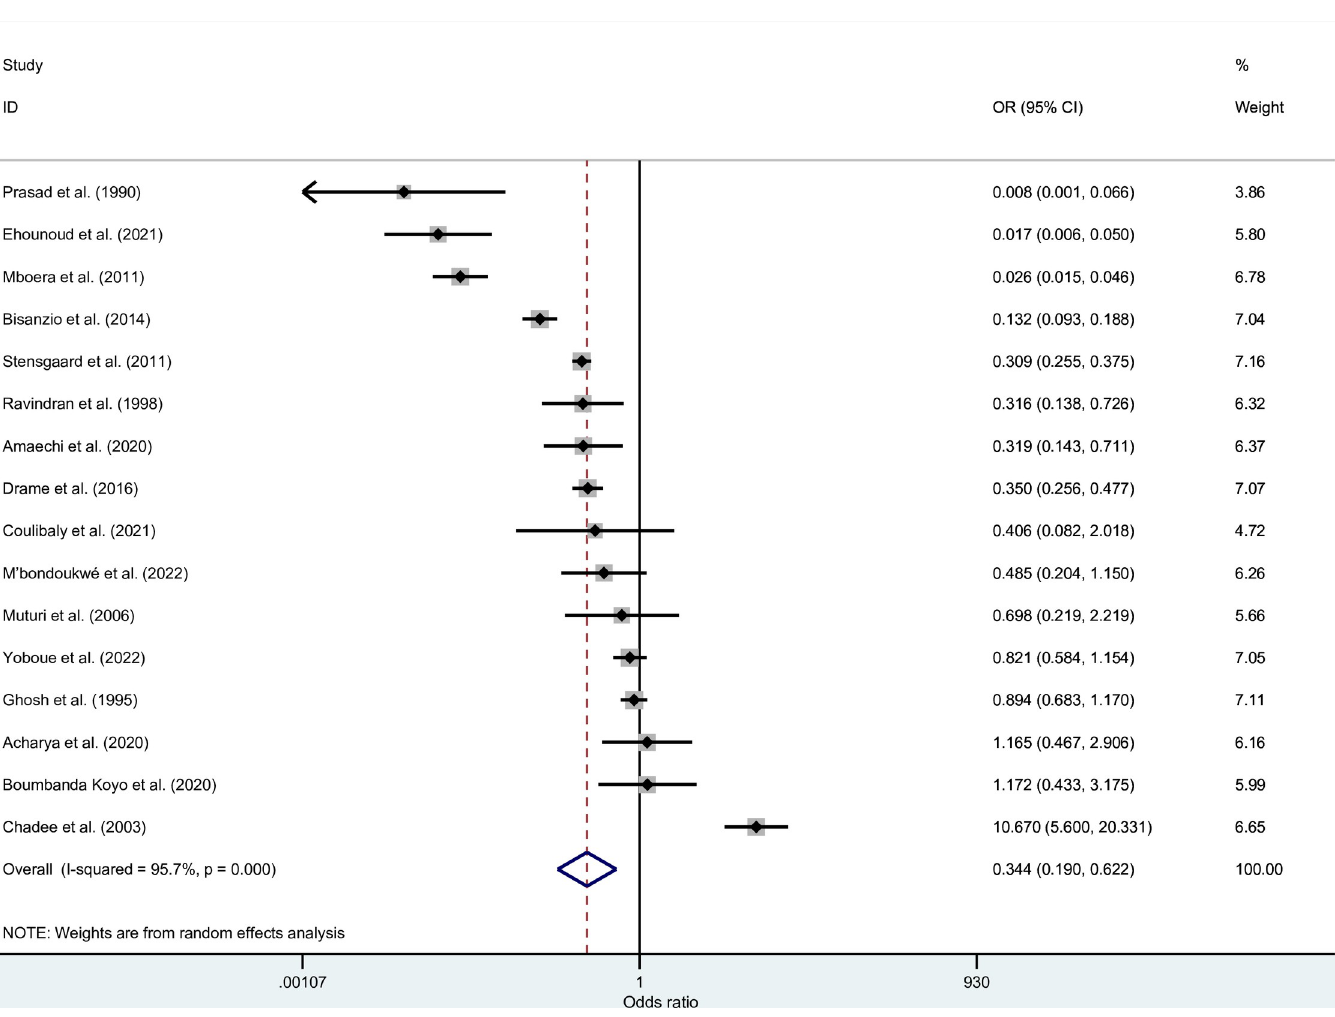
Fig 7. The odds of malaria and filariasis co-infections among selected studies. Abbreviations : OR- odds ratio; CI- confidence interval.